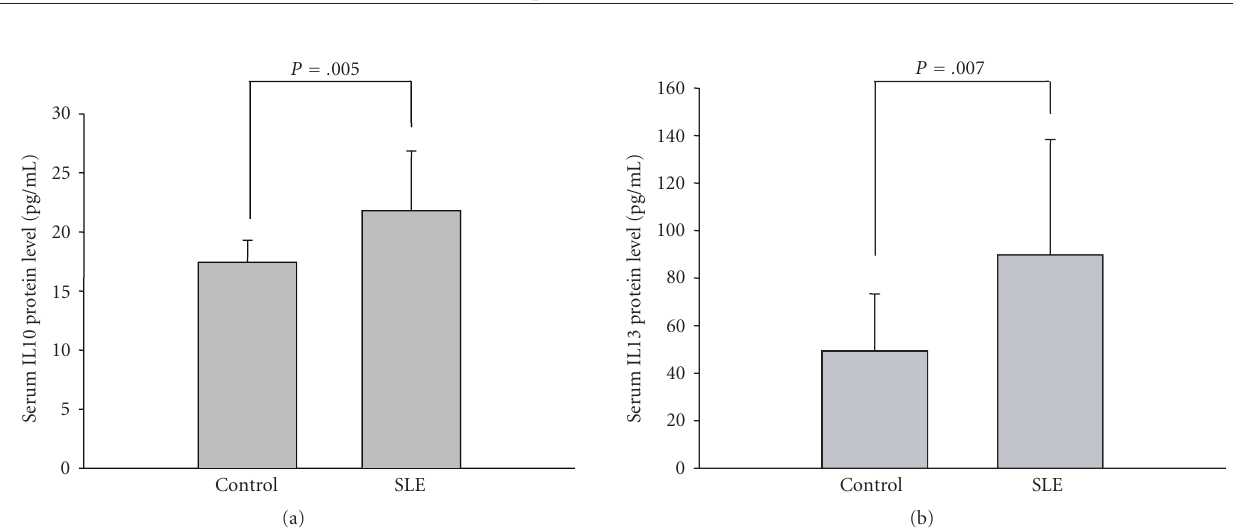
Figure 1: Serum IL-10 and IL-13 protein levels in SLE patients ( n = 15) and healthy controls ( n = 15). The mean concentration of IL-10 (a) and IL-13 (b) were detected by ELISA ( P = . 005; P = . 007).